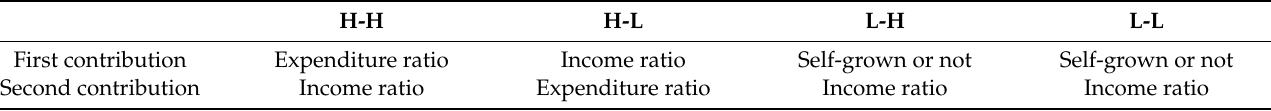
Table 4. Differences in factors influencing farmers’ willingness to grow food by region